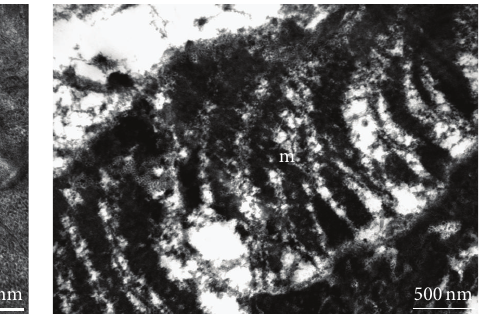
(a) Section magnification of a control nematode, showingthedetailedfinestructureofamusclecell(m)